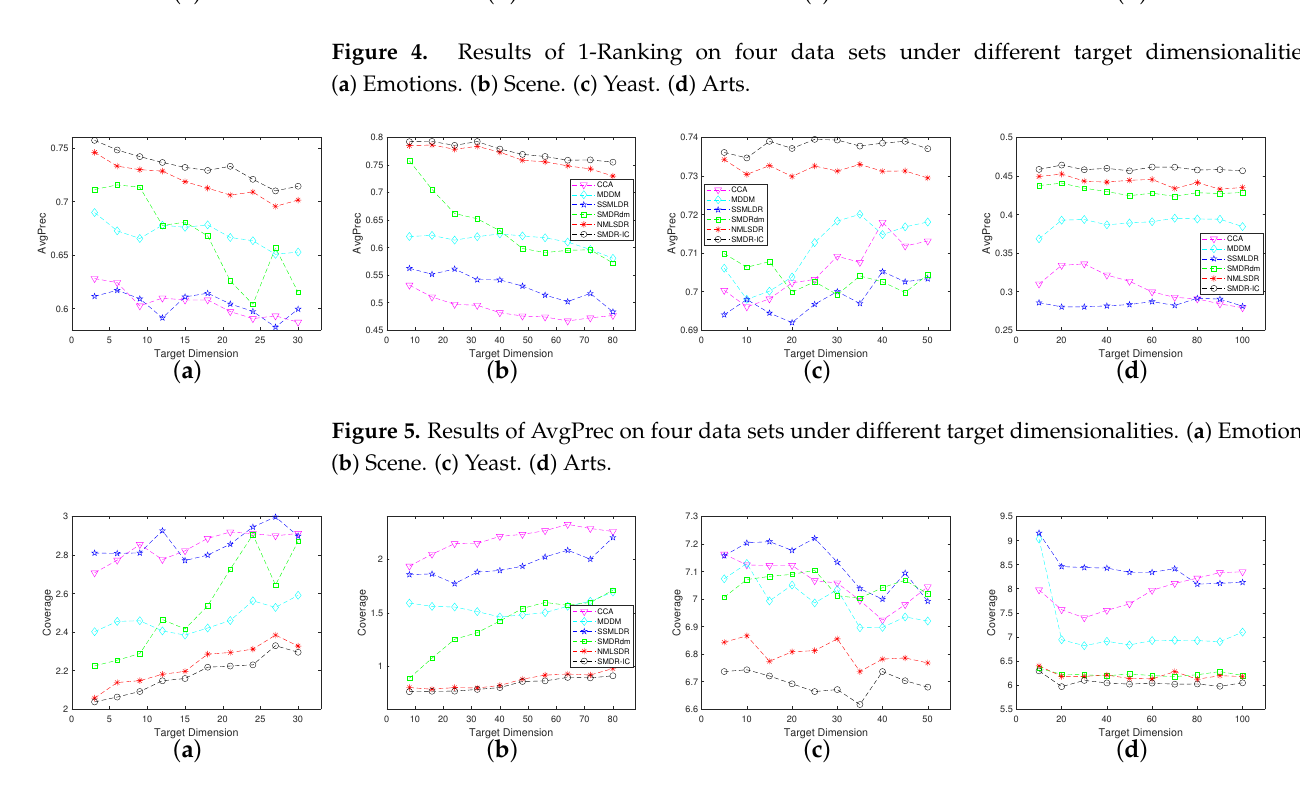
Figure 6. Results of Coverage on four data sets under different target dimensionalities. ( a ) Emotions. ( b ) Scene. ( c ) Yeast. ( d )